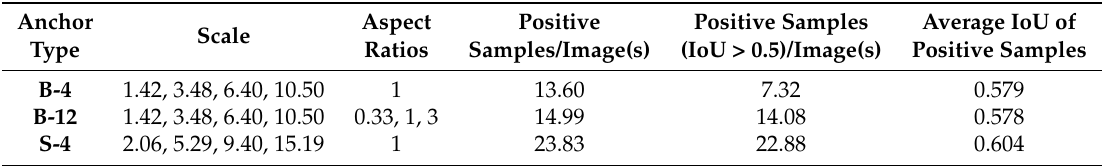
Table 1. The statistics of different types of anchors. B and S represent original anchor and square anchor respectively, followed by the number of anchors.